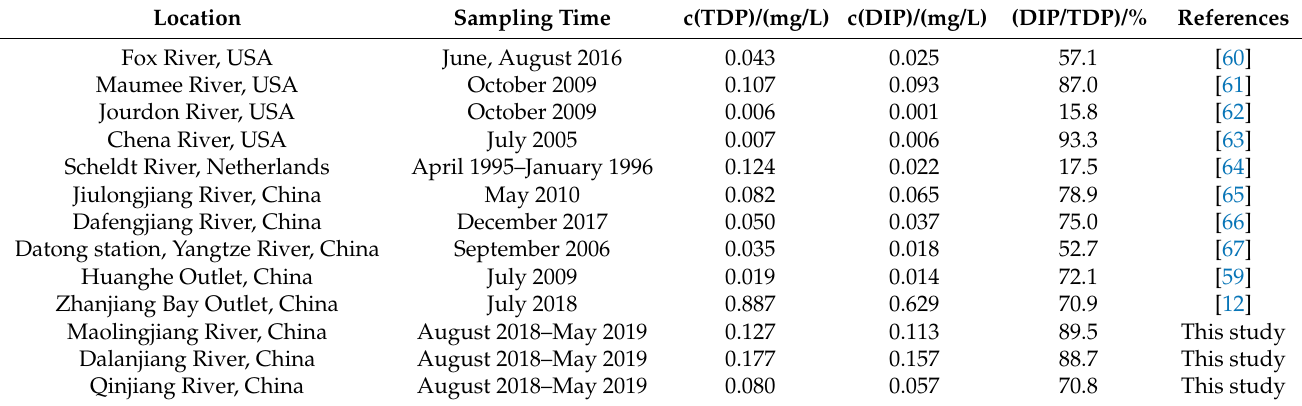
Table 3. Comparison of TDP average concentration and composition in different rivers.